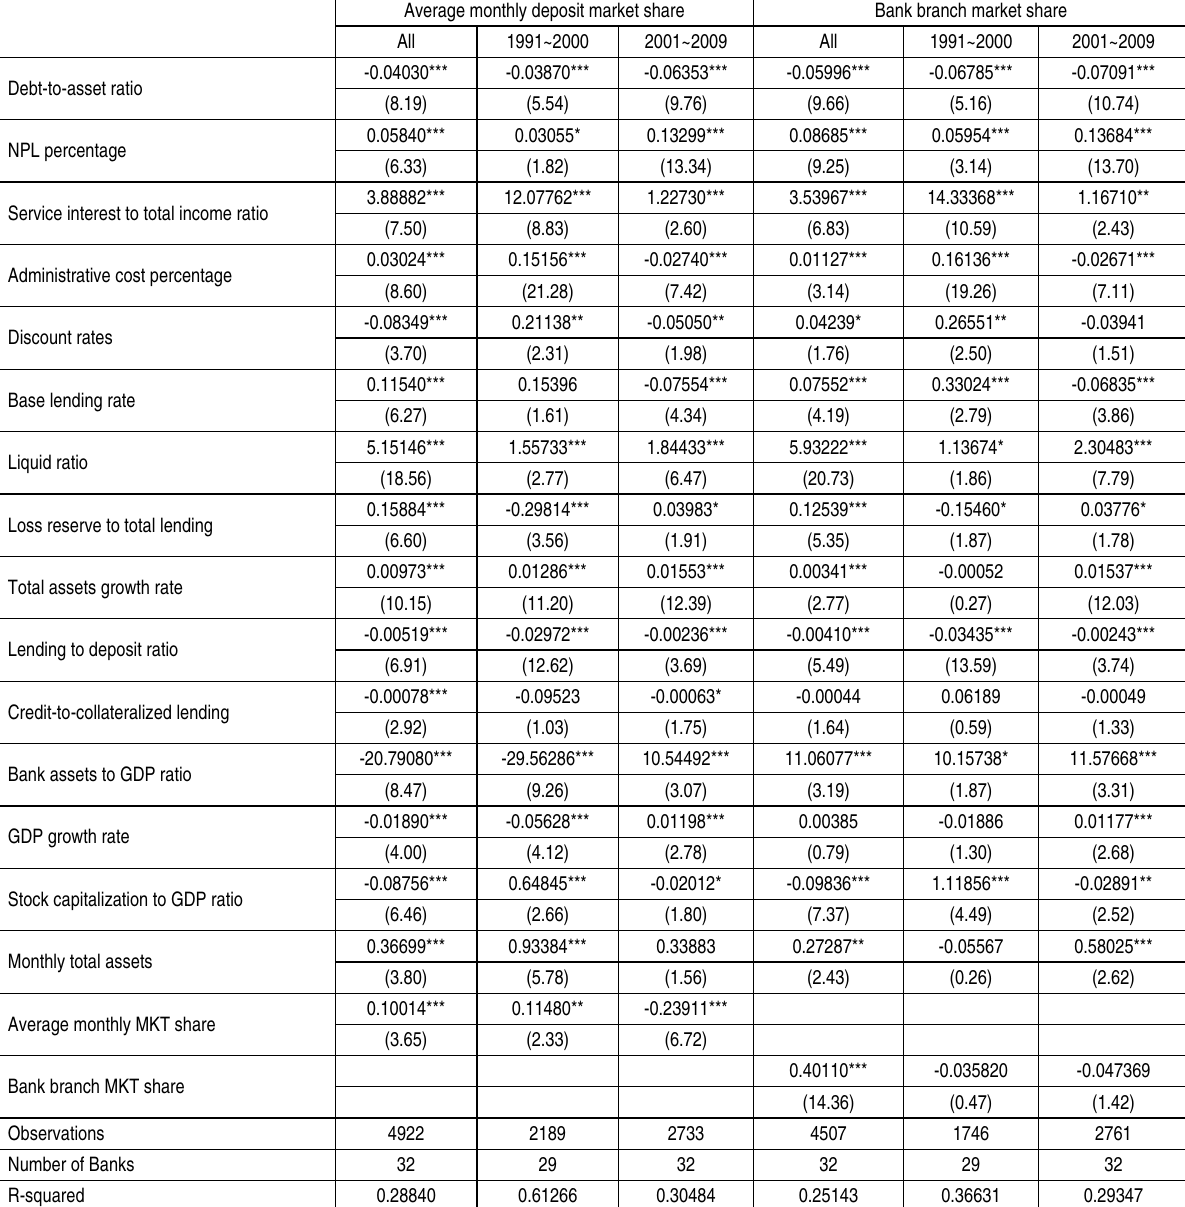
Table 4. Deposit and branch market shares – adding macroeconomic